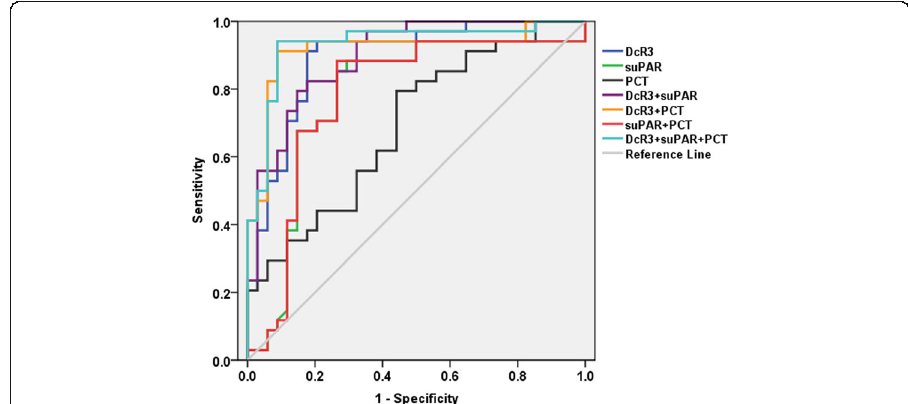
Fig. 5 ROC evaluation of DcR3, suPAR, PCT and DcR3 combined with suPAR, PCT in SIRS group vs. sepsis group. The ROC evaluation was performed at cut-off values recommended by the scientific community of laboratory medicine with 95% CI